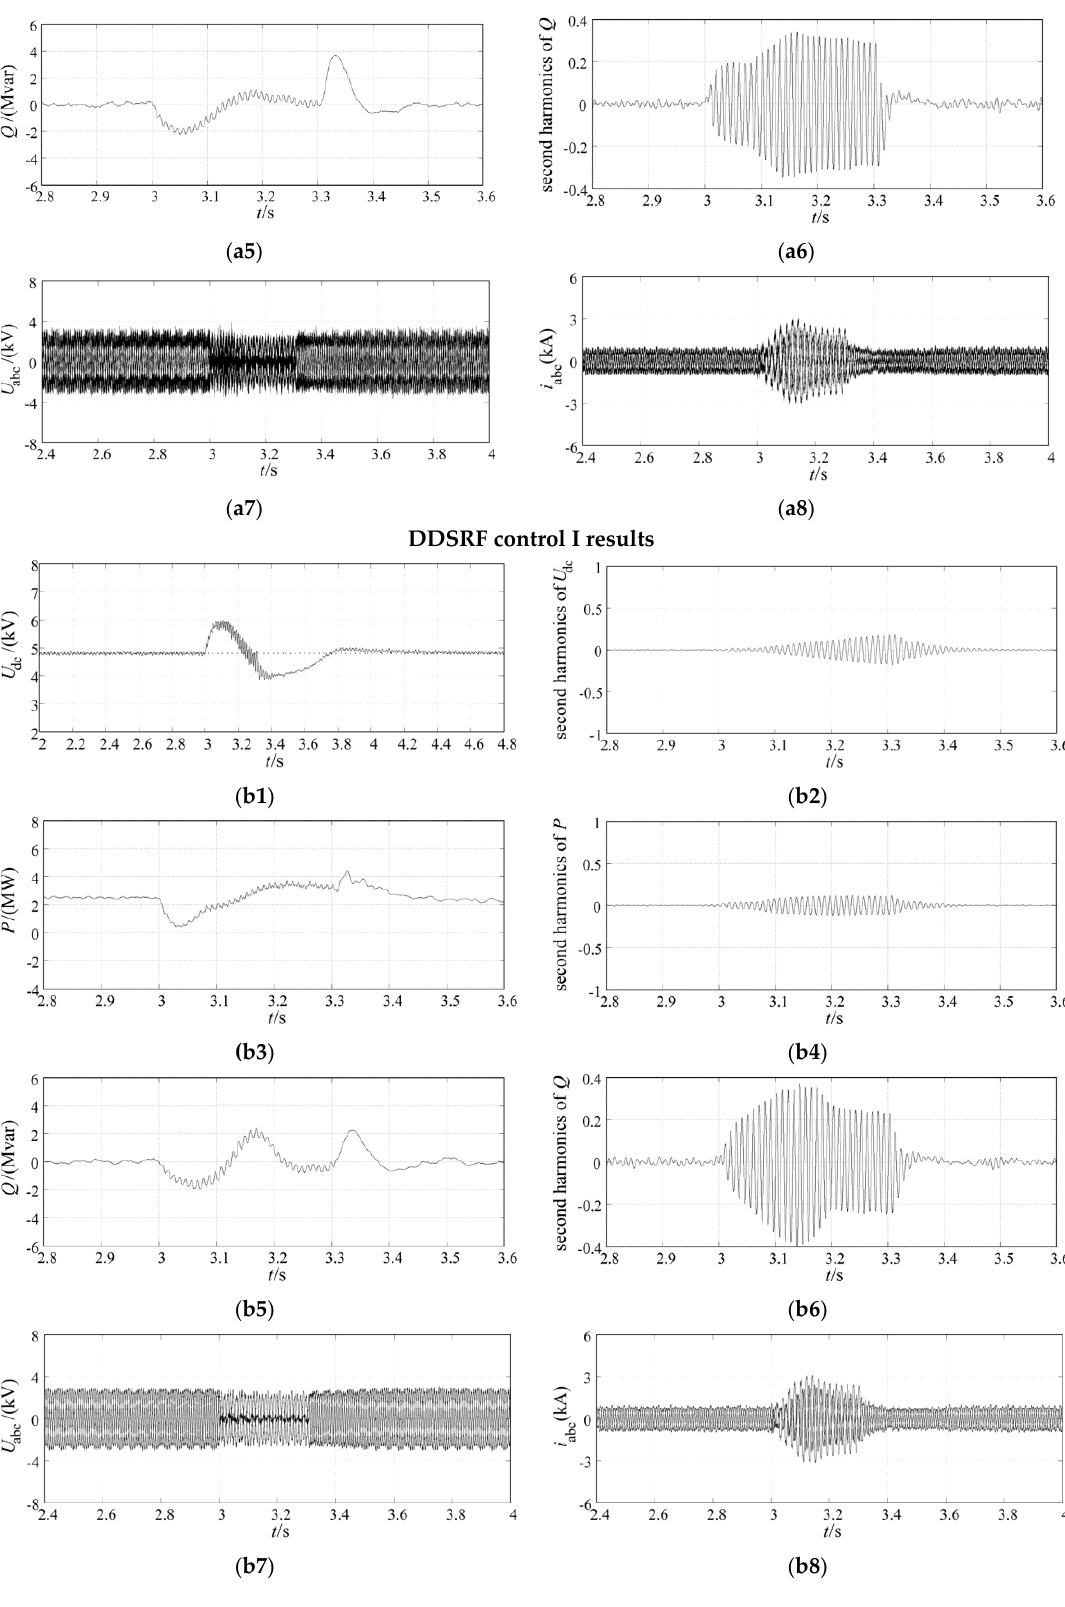
Figure 10. Cont. Figure 10.